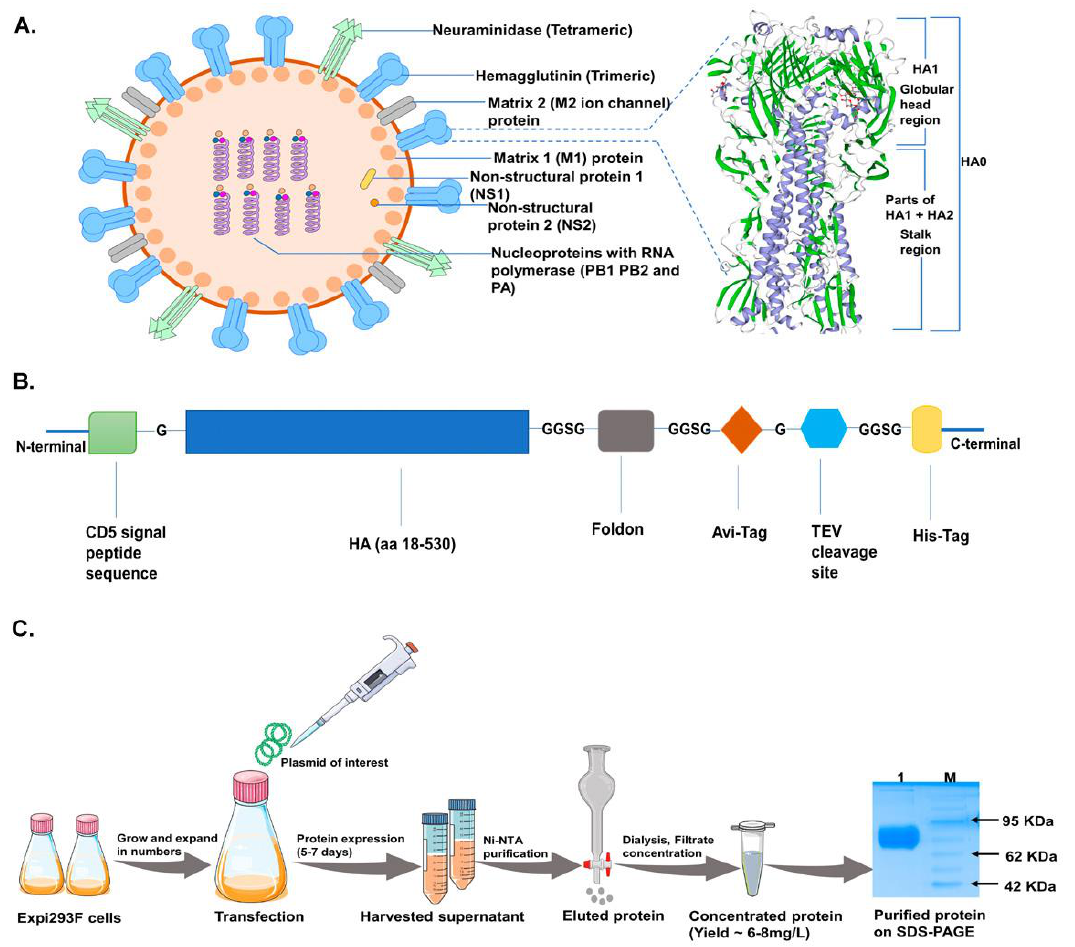
Figure 1. Construct design and protein production scheme in mammalian cells. ( A ): Typical Influenza virion structure along with a magnified view of HA-T-AGM 3-D structure (homo-trimer) as generated by the Swiss-model ExPASy online tool based on secondary structure features (purple strands show α -helices and green highlight are β -sheets). ( B ): Schematic representation of expression cassette used in mammalian pcDNA3.1 expression vector ( C ): Schematic diagram showing expression and purification of HA-T-AGM protein in Expi293F cells i.e plasmid transfection and protein production and purification stages with final eluted fraction, dialyzed and run on 12% resolving gel.